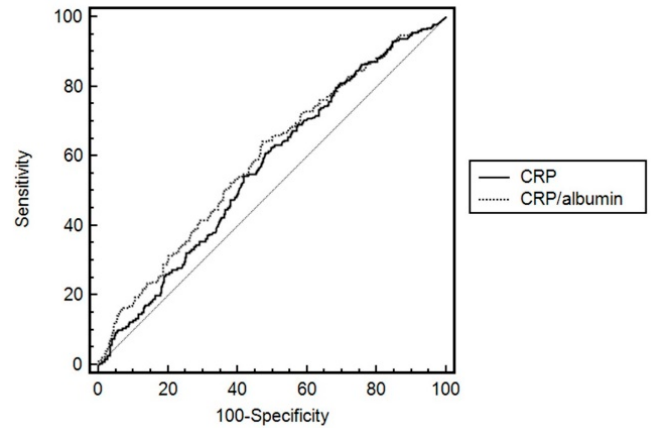
Figure 2. ROC curves of CRP and CRP/albumin ratio as 28-day mortality predictors. The AUC of CRP/albumin ratio was higher than that of CRP for mortality in ICU patients ( p < 0.001). ROC, receiver operating characteristic; CRP, C-reactive protein; AUC, area under the curve.